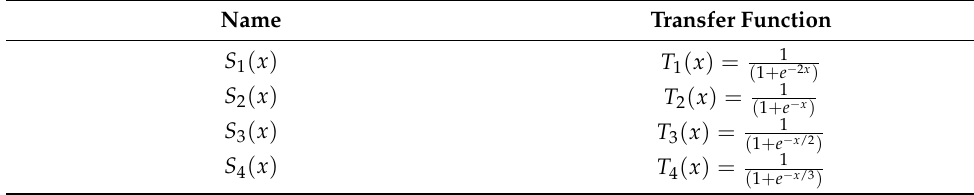
Table 2. The expressions of the S-shaped families of transfer functions.